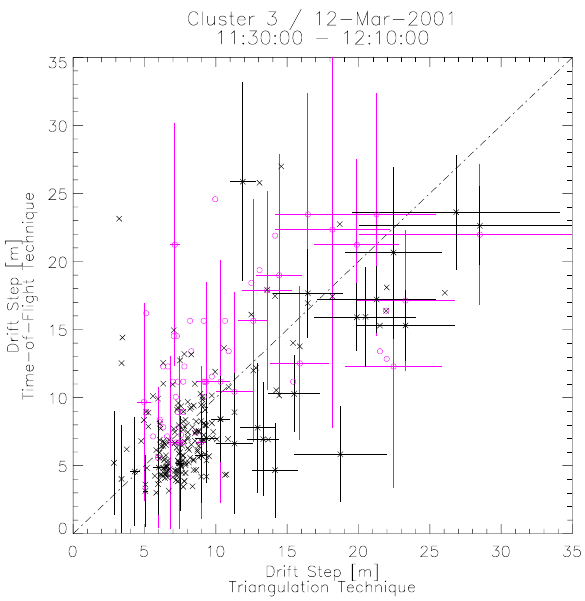
Fig. 9. Scatter plot of the drift speeds derived by the time-of- flight analysis (vertical axis) against those from the triangulation analysis (horizontal axis), for the interval 11:30 through 12:10 on 12 March 2001, on SC3. The two types of symbols refer to the dif- ferent time-of-flight analysis methods, as in Fig. 8. Error bars are only shown for a fraction of the points so as not to clutter the